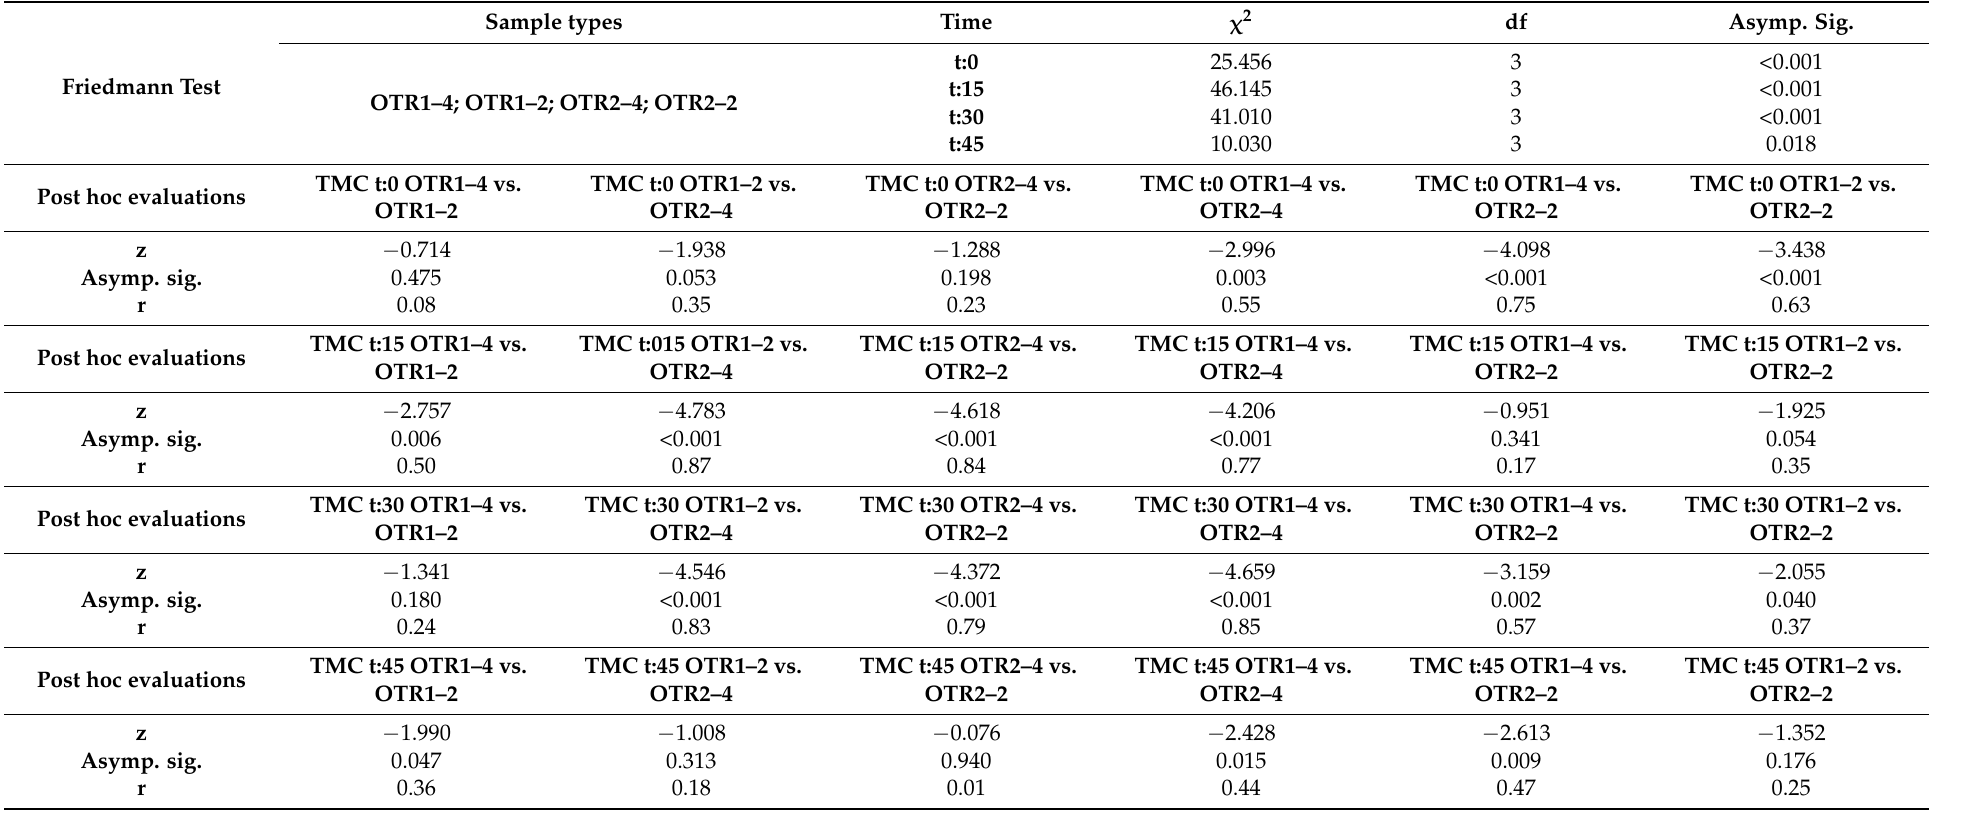
Table 7. Statistical results and respective post hoc inferences concerning TMC values and OTR1–2